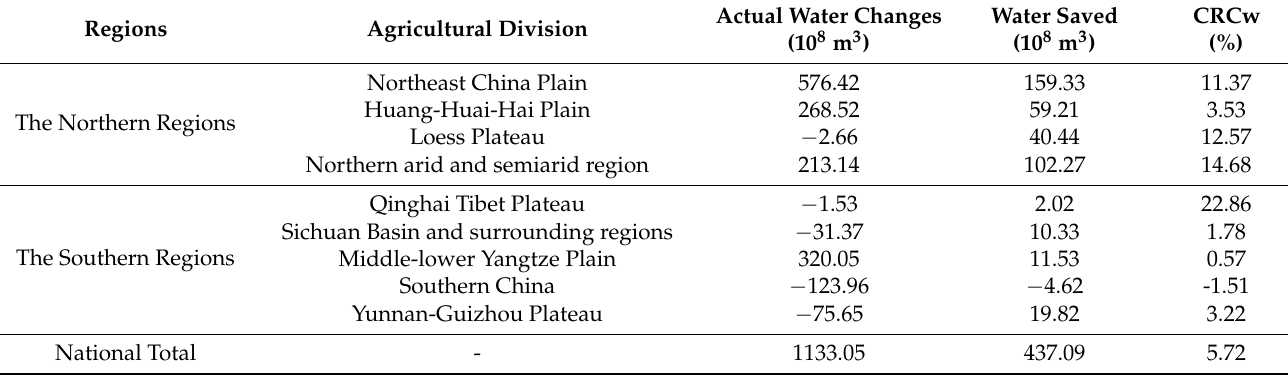
Table 2. Effect of grain planting structure adjustment on water resources consumption during 2003–2019.